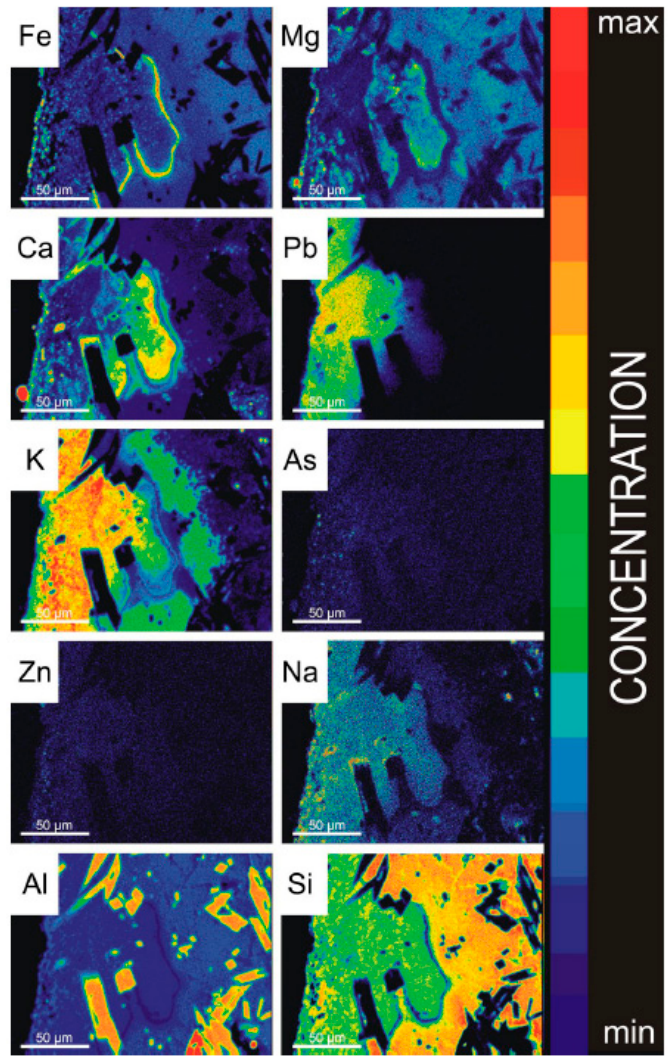
Figure 7. EPMA mapping showing concentrations of selected elements near the crack in the refractory materials.